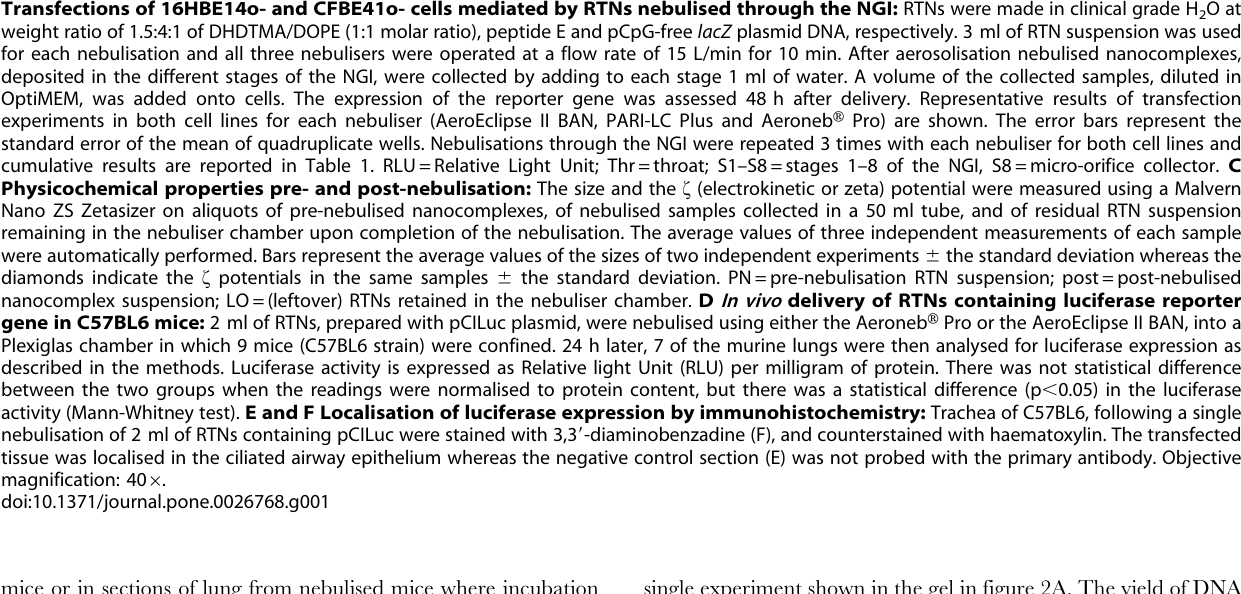
Figure 1. Comparison of vector delivery with three nebulisers (AeroEclipse II BAN, PARI-LC Plus and Aeroneb H Pro). A and B Transfections of 16HBE14o- and CFBE41o- cells mediated by RTNs nebulised through the NGI: RTNs were made in clinical grade H 2 O at weight ratio of 1.5:4:1 of DHDTMA/DOPE (1:1 molar ratio), peptide E and pCpG-free lacZ plasmid DNA, respectively. 3 ml of RTN suspension was used for each nebulisation and all three nebulisers were operated at a flow rate of 15 L/min for 10 min. After aerosolisation nebulised nanocomplexes, deposited in the different stages of the NGI, were collected by adding to each stage 1 ml of water. A volume of the collected samples, diluted in OptiMEM, was added onto cells. The expression of the reporter gene was assessed 48 h after delivery. Representative results of transfection experiments in both cell lines for each nebuliser (AeroEclipse II BAN, PARI-LC Plus and Aeroneb H Pro) are shown. The error bars represent the standard error of the mean of quadruplicate wells. Nebulisations through the NGI were repeated 3 times with each nebuliser for both cell lines